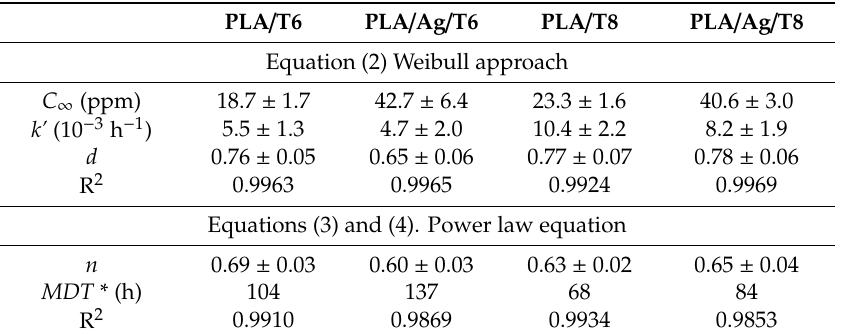
Table 3. Fitting parameters of Equations (2)–(4) to experimental migration data of thymol loaded